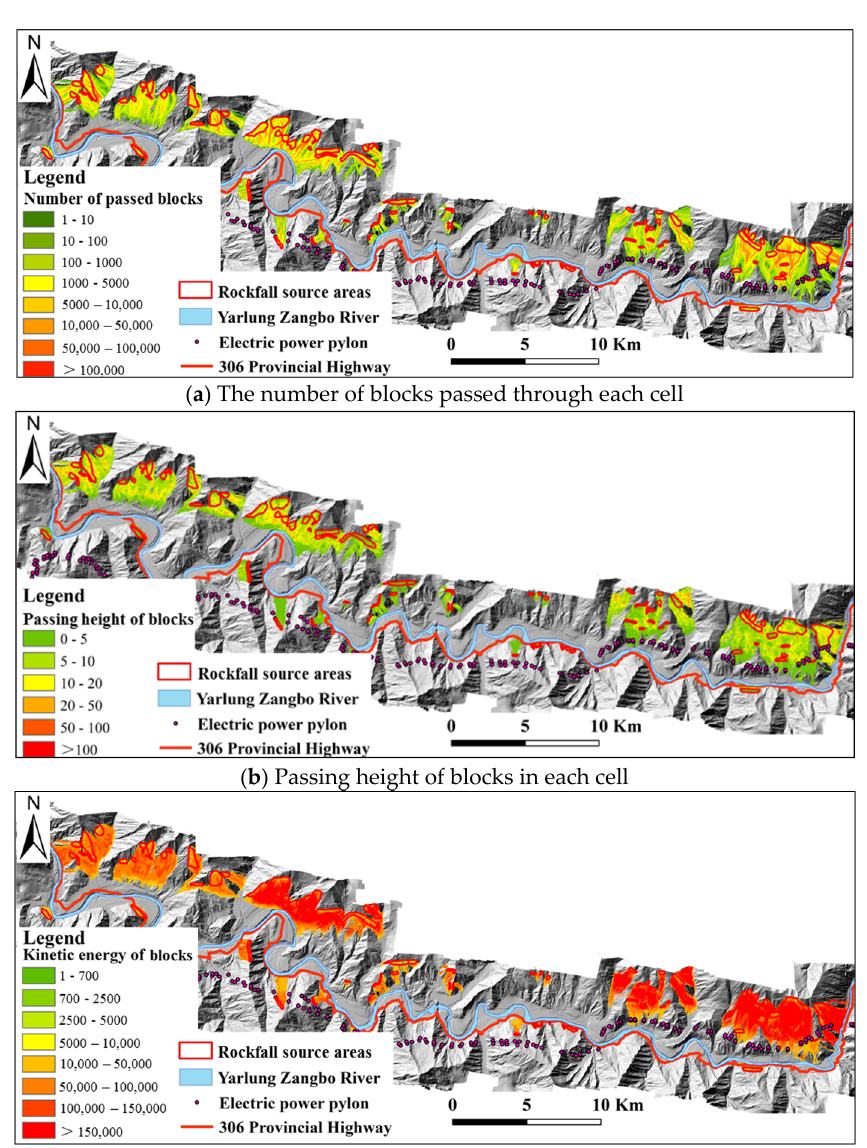
Figure 8. Numerical simulation results of rockfalls in the study area.